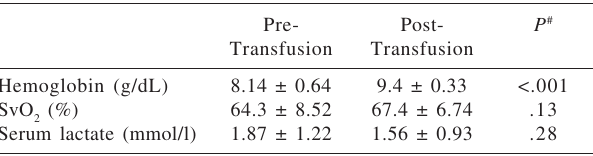
Table 2 - Hemoglobin, mixed venous oxygen saturation and serum lactate pre- and post-transfusion global analysis Pre- Post- P # Transfusion Hemoglobin